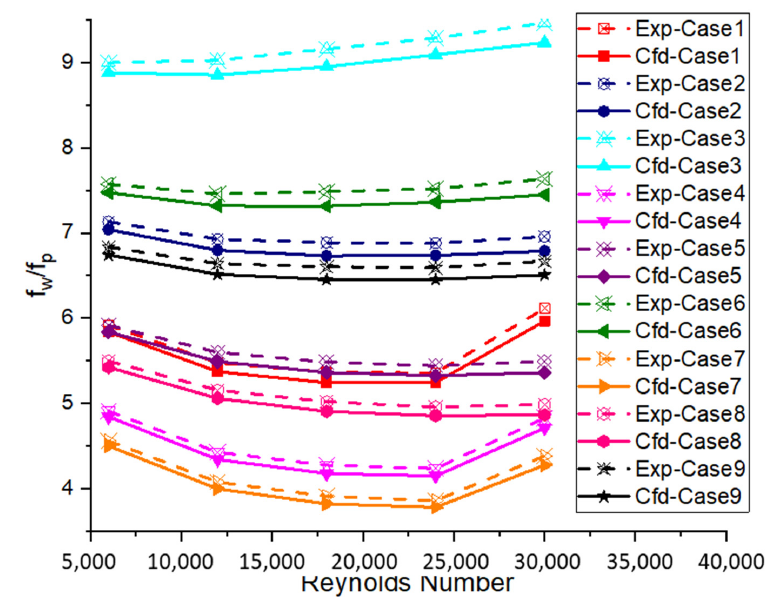
Figure 12. Augmented values of Friction factor Ratio over Reynolds Number.